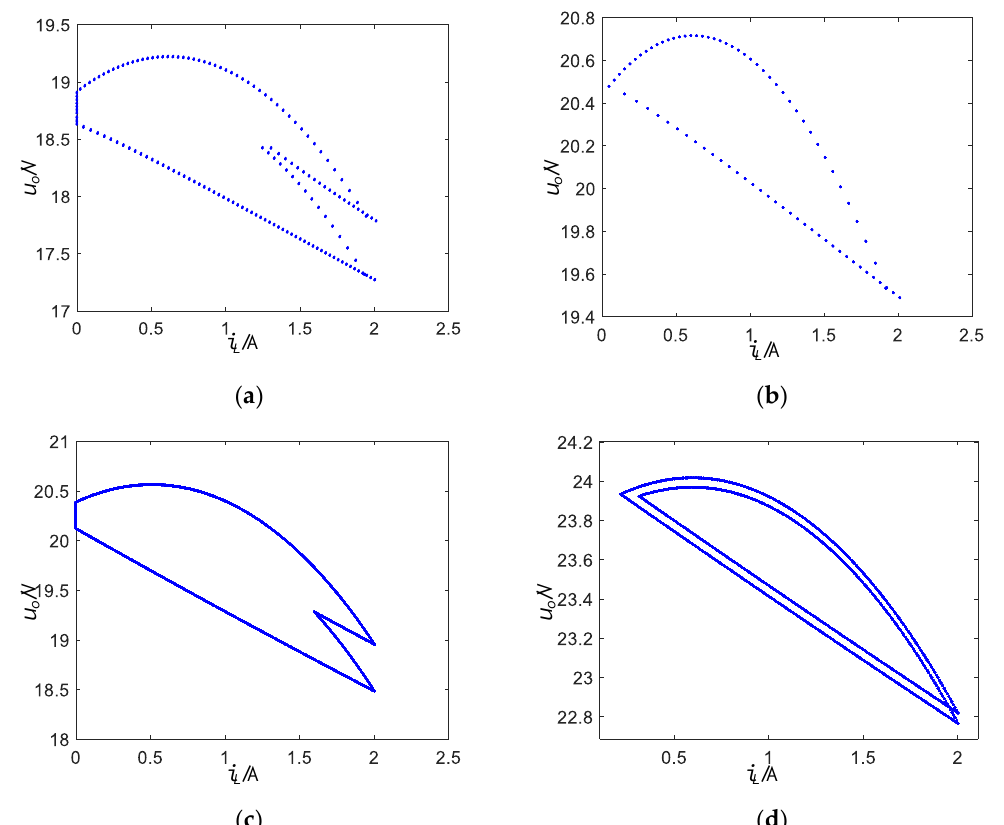
Figure 10. The V-I phase portrait of the different values of the input voltage: ( a ) U in = 16.5V, α = β = 0.85; ( b ) U in = 25V, α = β = 0.85; ( c ) U in = 16.5V, α = β = 1; and ( d ) U in = 25V, α = β = 1. The phase portrait of the FO buck–boost converter are shown in Figure 11. Figure 11 shows that when fractional-order α = β = 0.72, the period-1 solution is stable